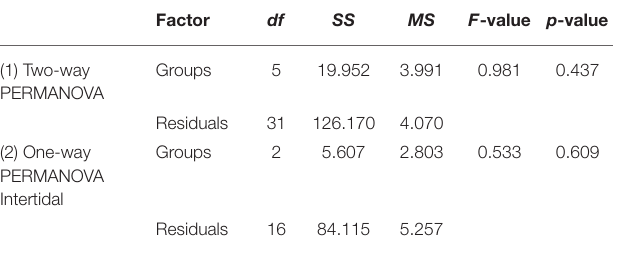
TABLE 1 | Results from tests for homogeneity of multivariate dispersions for PERMANOVAs assessing (1) the effect of environment and time on coral health across all surveyed coral genera and (2) the effect of time on coral health across all surveyed coral genera in the intertidal